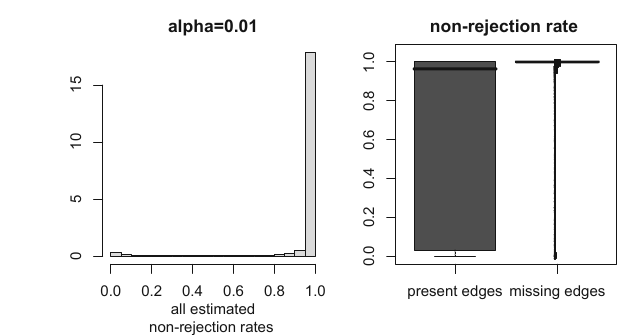
G with n = 20, q = 1, α = 1